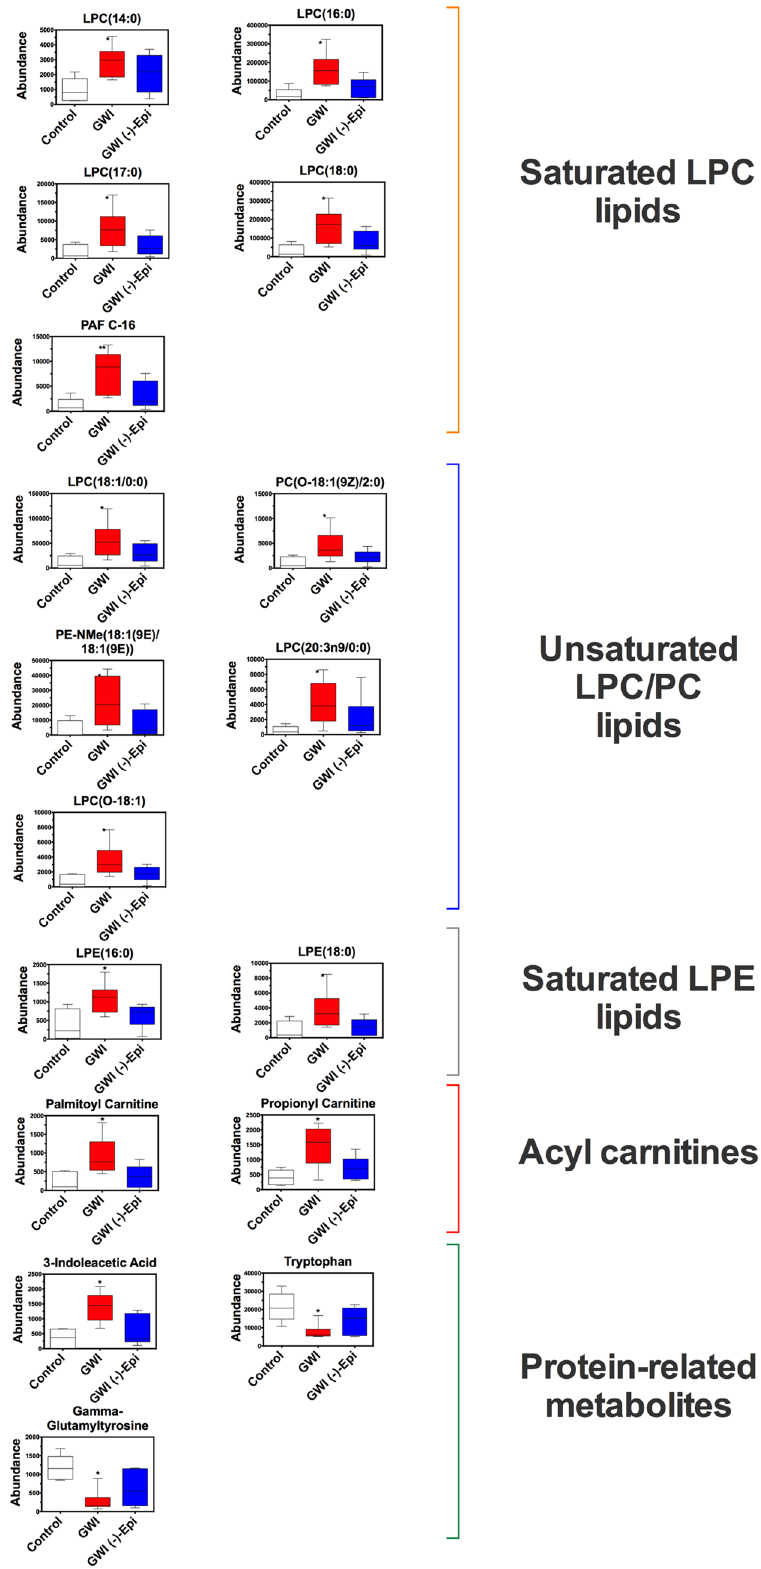
Figure 5. Effects of (−)-epicatechin (Epi) on GWI rat plasma metabolites. Results are expressed as median and 10–90 percentile and visualized as box plots. *p < 0.05 vs. control, **p < 0.01 vs. control, Kruskal–Wallis–Dunn’s multiple comparison post hoc